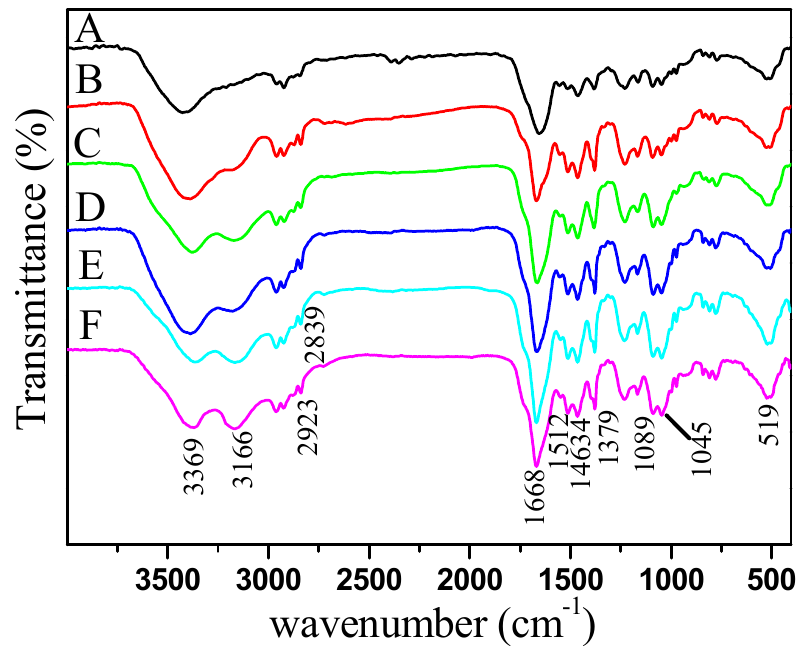
Figure 2. FTIR spectra of reactive extruded MP/PER masterbatches with different molar ratio: (A) MP/PER = 1.0; (B) MP/PER = 1.2; (C) MP/PER = 1.4; (D) MP/PER = 1.6; (E) MP/PER = 1.8; (F) MP/PER = 2.0.